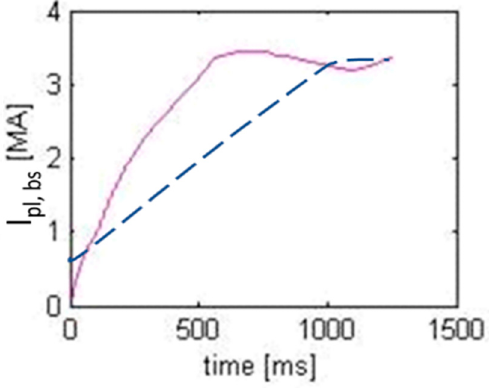
Figure 2. Evolutions of the total plasma current (dushed line) and the bootstrap current I bs (solid), calculated by DINA-ASTRA simulation for STEP [30]. The bootstrap overdrive condition is achieved in this example.